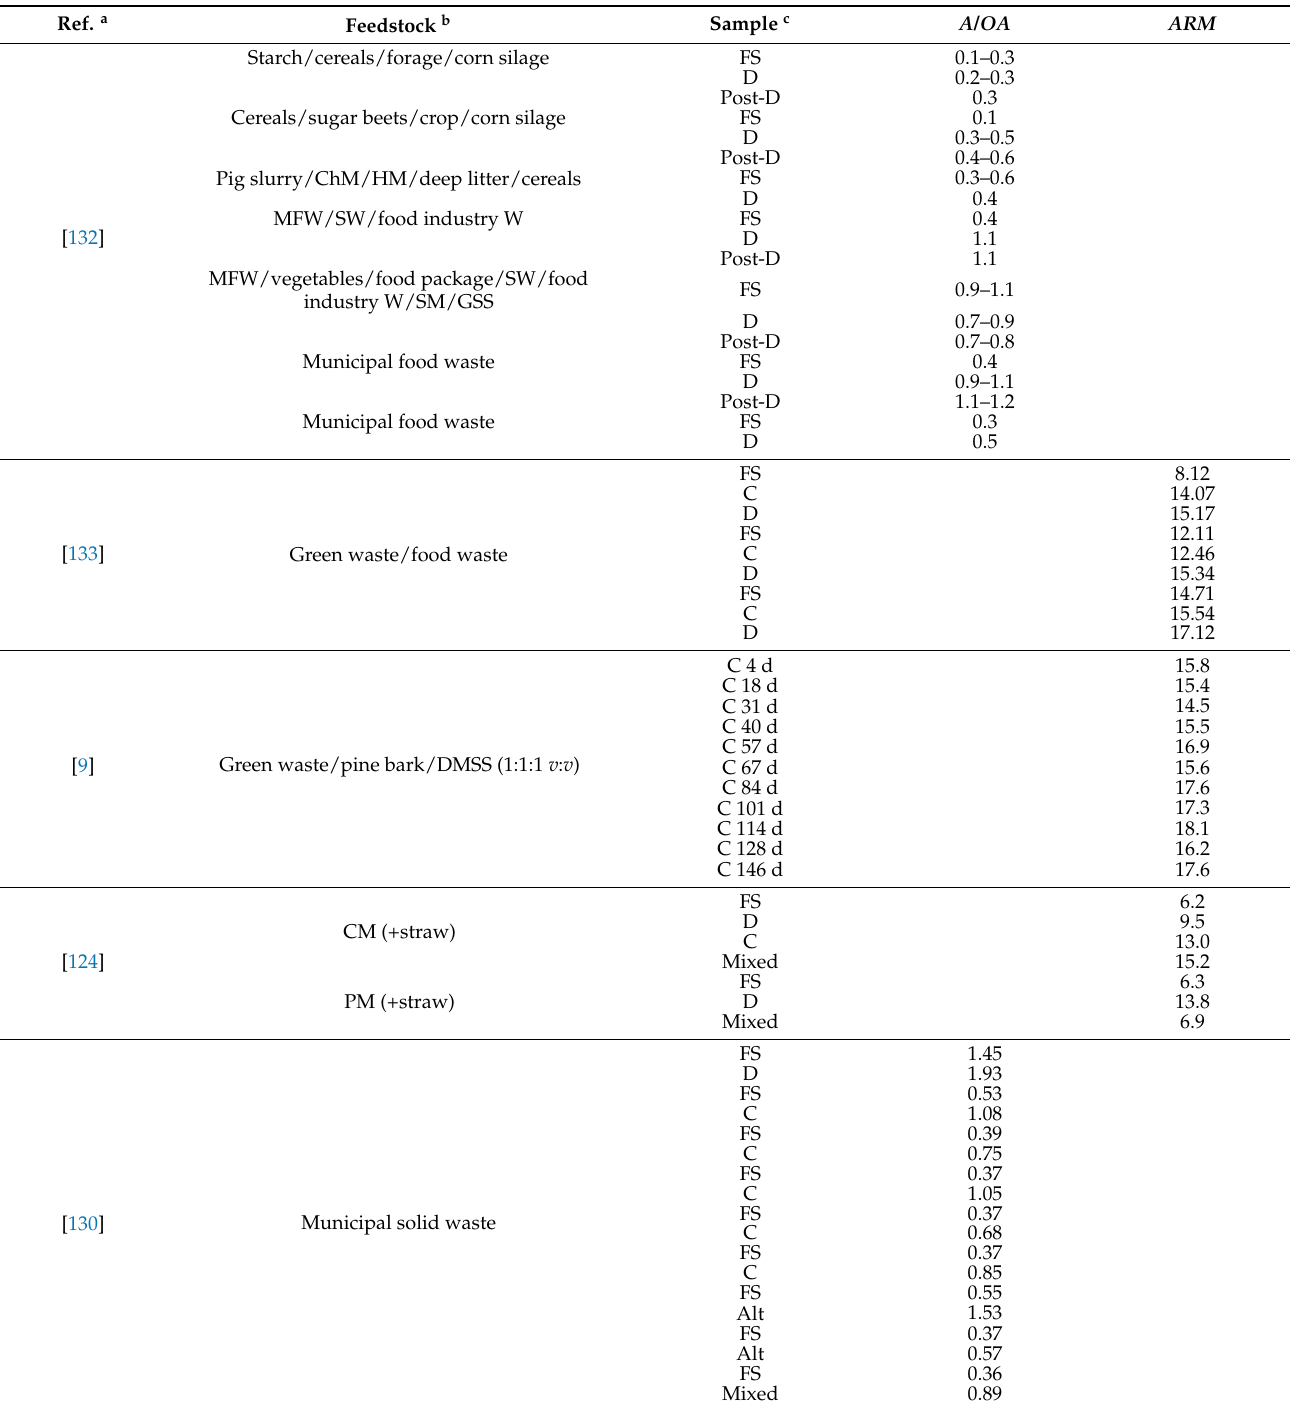
Table 7. A/OA and ARM indices determined from 13 C CP-MAS NMR spectra for digestate samples and corresponding feedstocks reported in the